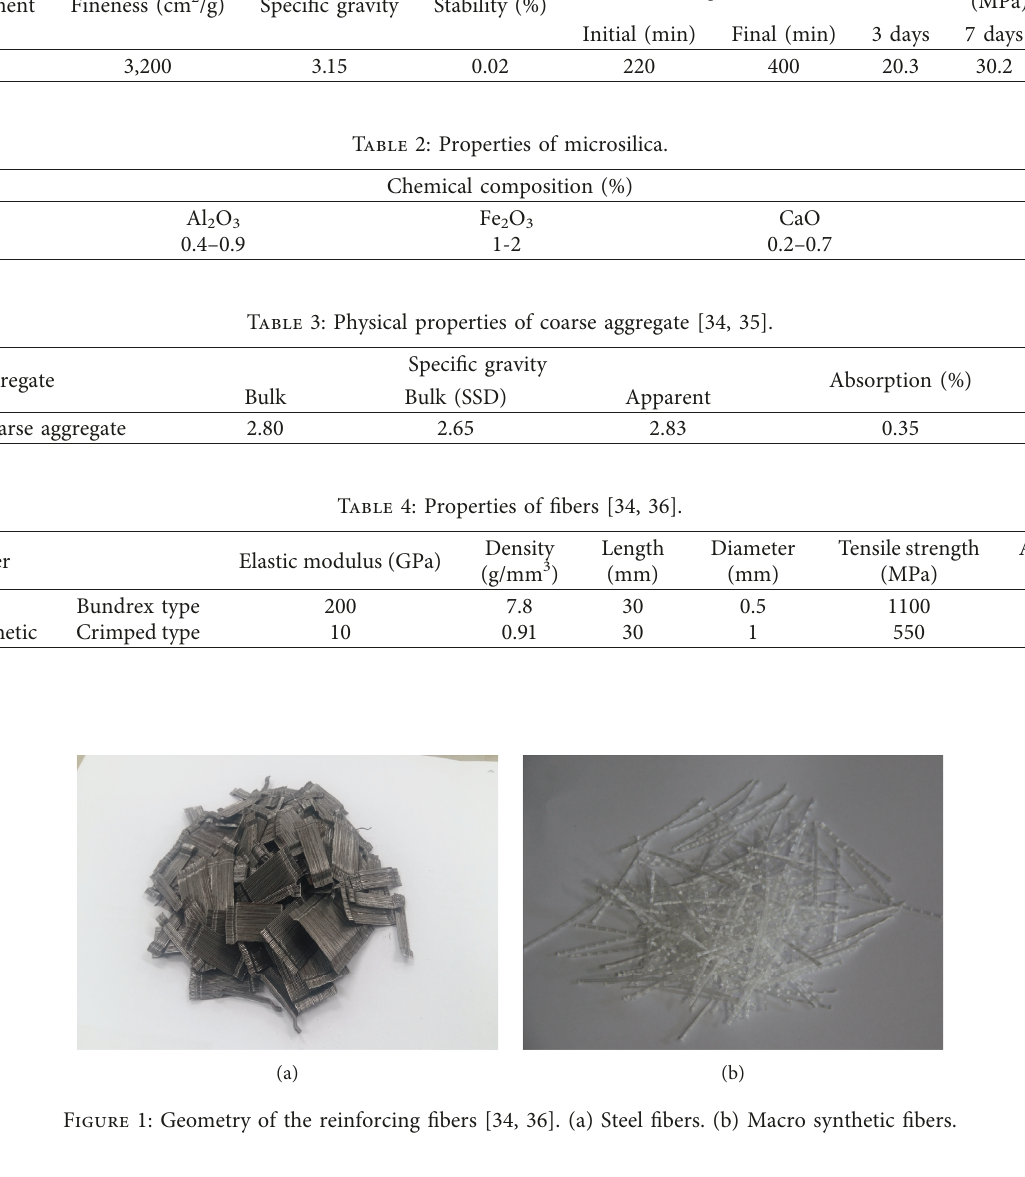
Table 6. The target compressive strengths of the latex-